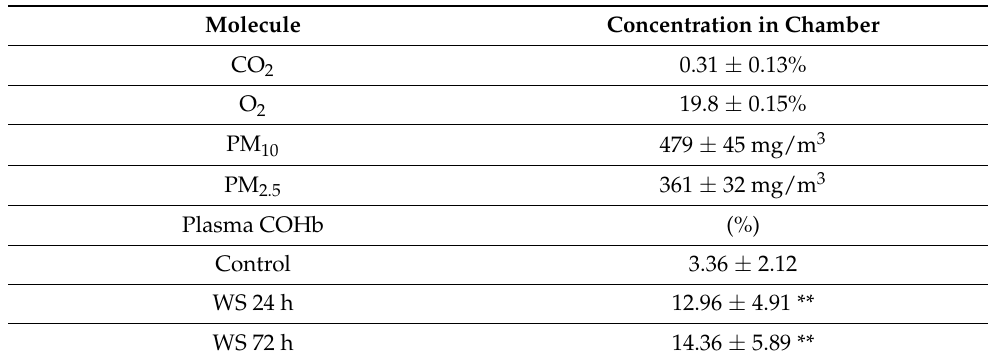
Table 2. WS composition and carboxyhemoglobin (COHb)